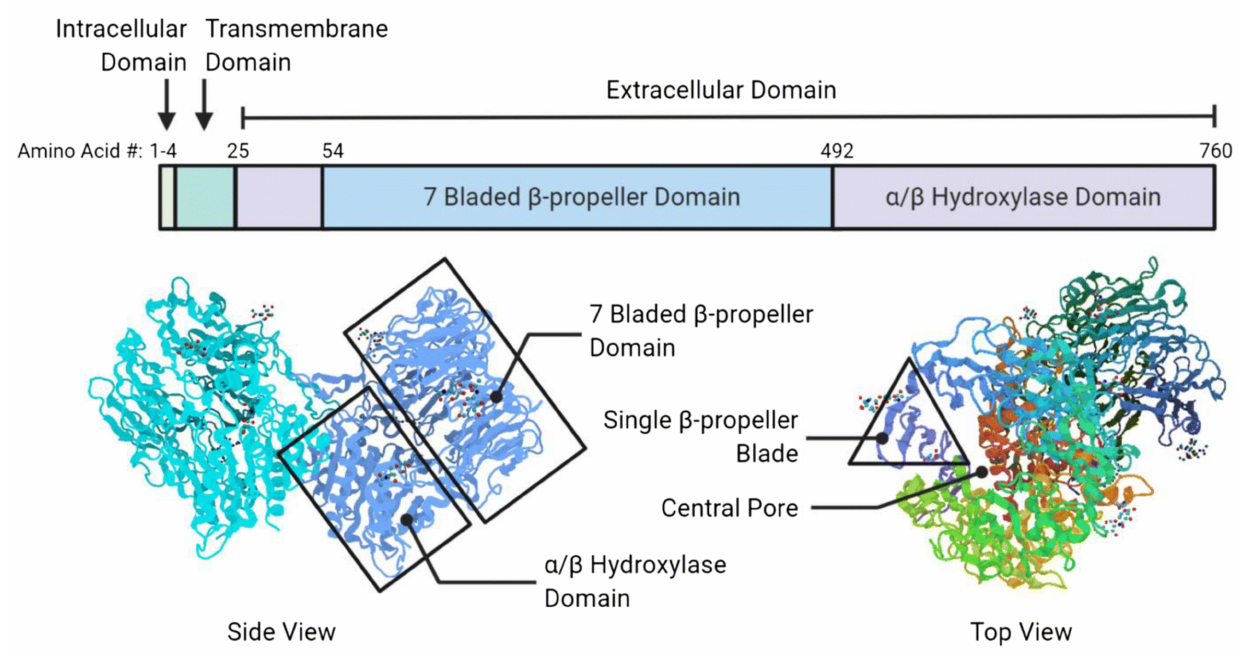
Figure 4. Schematic representations of FAP structural compositions (top panel) and its protein scaffold (bottom panel). In the protein scaffold, the central pore, seven-bladed β -propeller, single β -propeller, and α / β hydroxylase domains are identified. “#” represents the position of the amino acid residue in FAP domains. The figure is reproduced with permission from